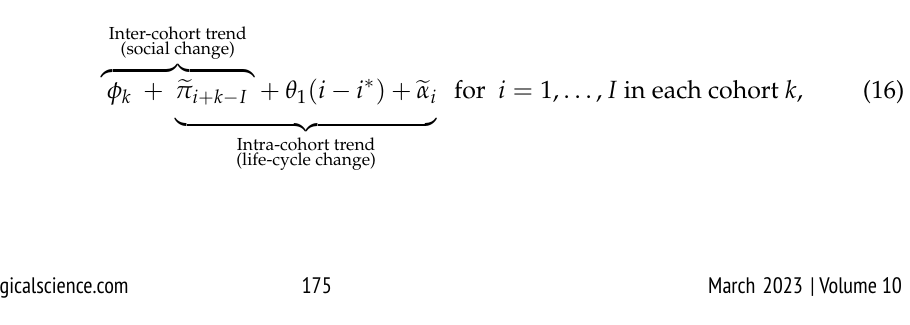
γ k + π k + i − I for (cid:101) (cid:101)